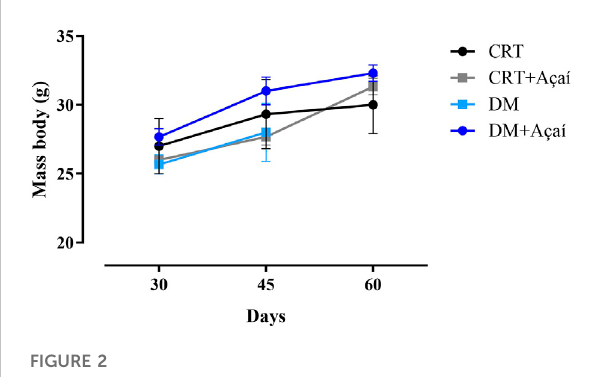
FIGURE 2 Mass body (g) monitoring after diabetes induction. Values are means±SD.At30,45,and60 days afterdiabetesinduction,therewas no statistical difference in the comparison of body mass between groups ( p > 0.05).